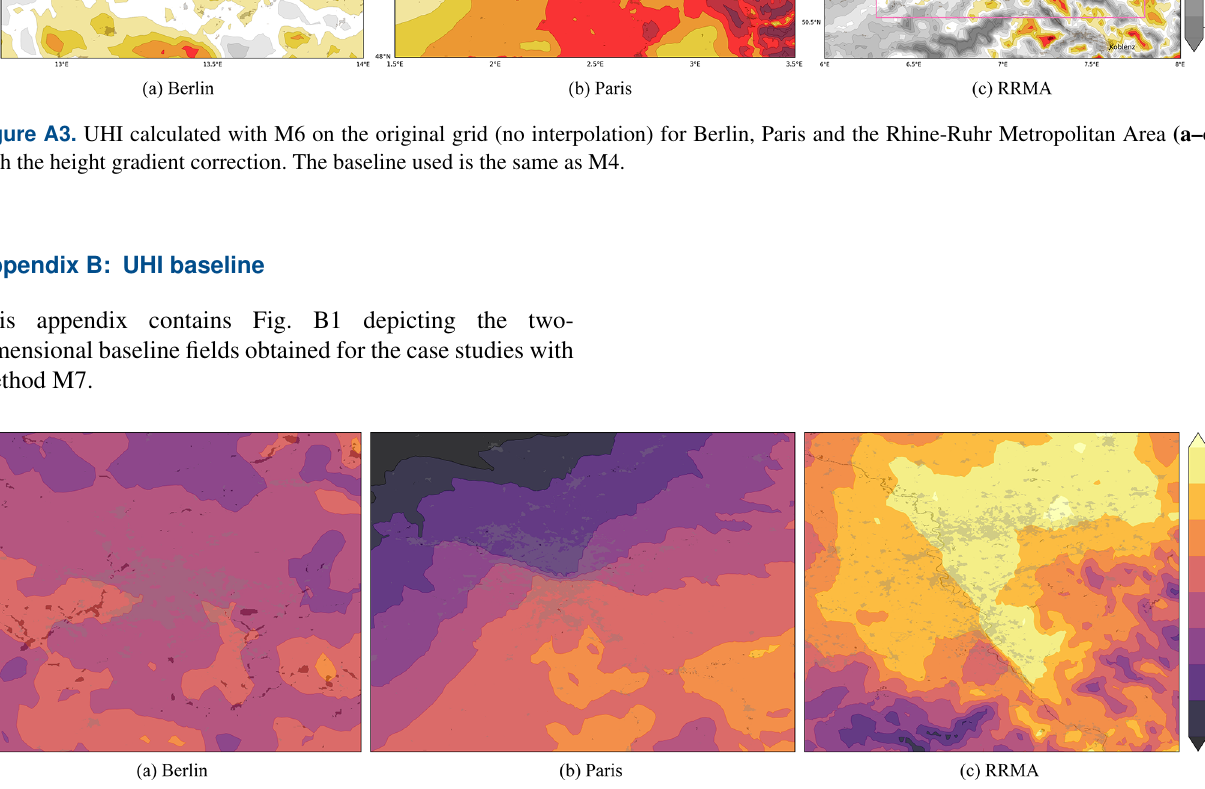
Figure B1. Baseline fields as estimated with M7 on the original grid (no interpolation) for Berlin, Paris and the Rhine-Ruhr Metropolitan Area (a–c)